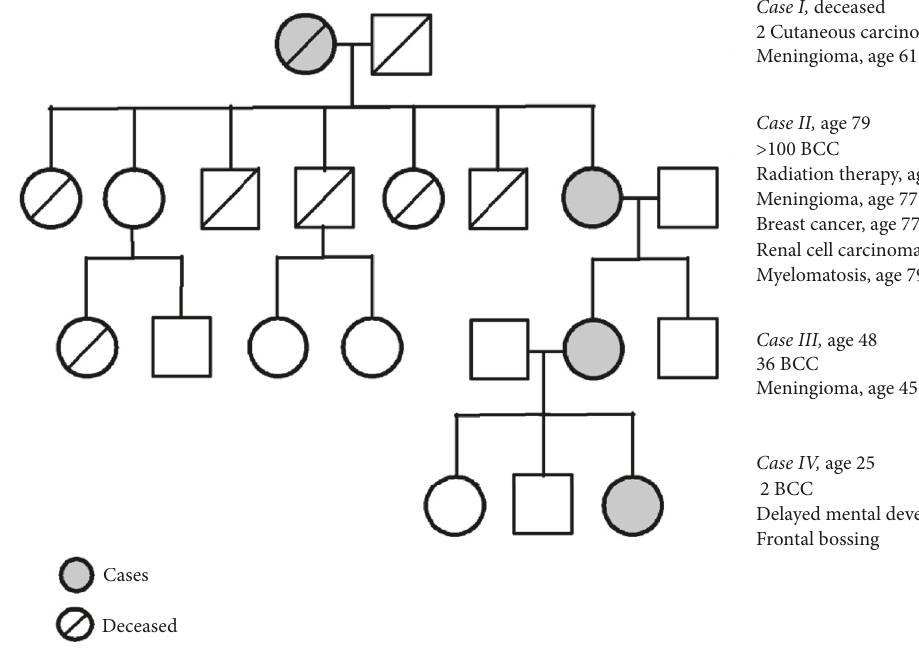
Figure 1: Pedigree. Cases are marked with grey and their most relevant medical history is listed to the